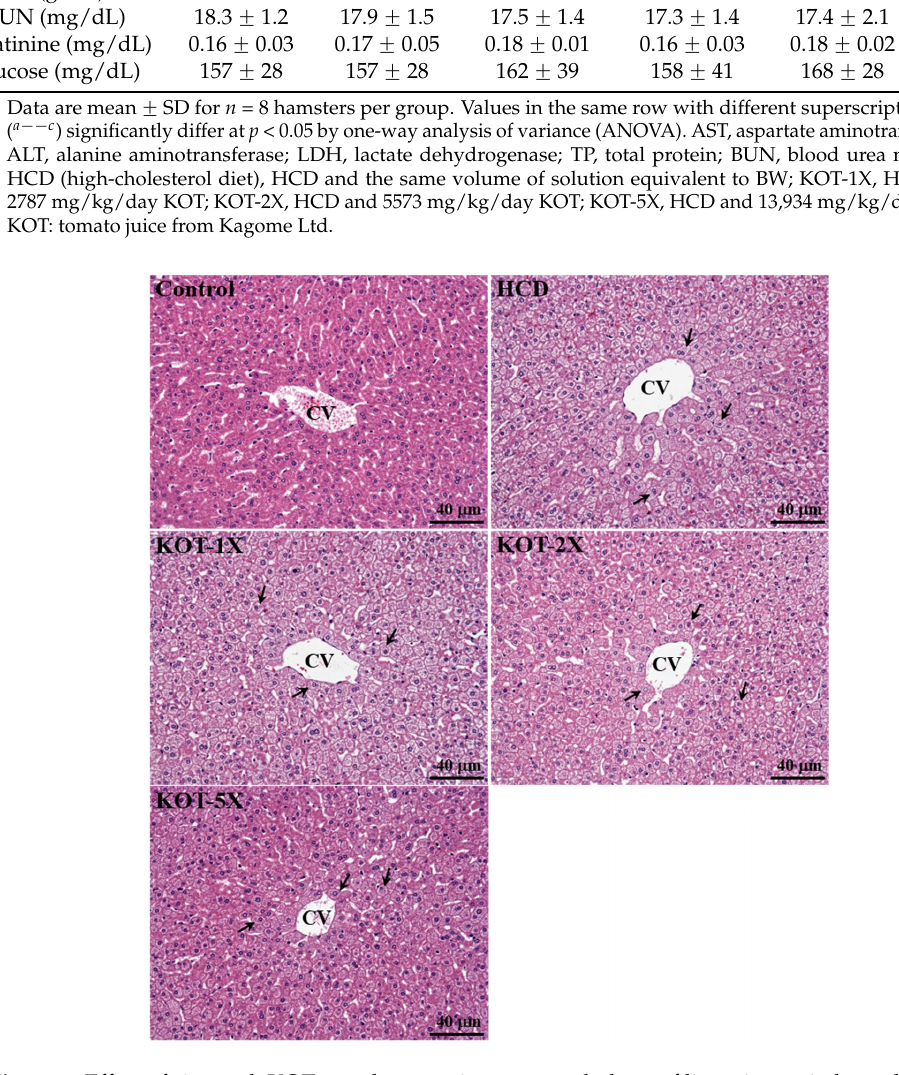
Figure 6. Effect of six-week KOT supplementation on morphology of liver tissues in hyperlipidemic hamsters. Arrows indicate fat droplets. Specimens were photographed by light microscopy. CV, central vein. (H & E stain, magnification: ˆ 200, Scale bar, 40 µ m). HCD (high-cholesterol diet), HCD